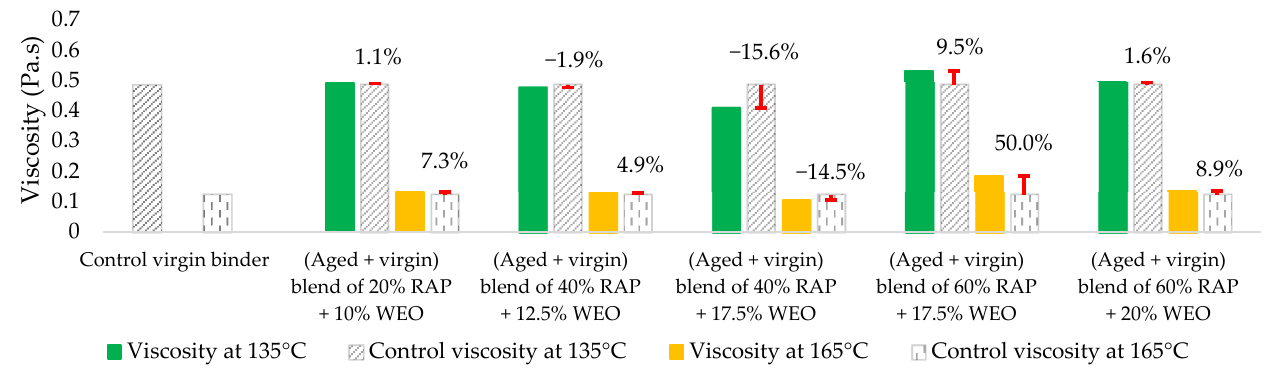
Figure 18. The change in viscosity level from adding WEO as a rejuvenator to the combined blend of binders in comparison to the control viscosity of the virgin binder.